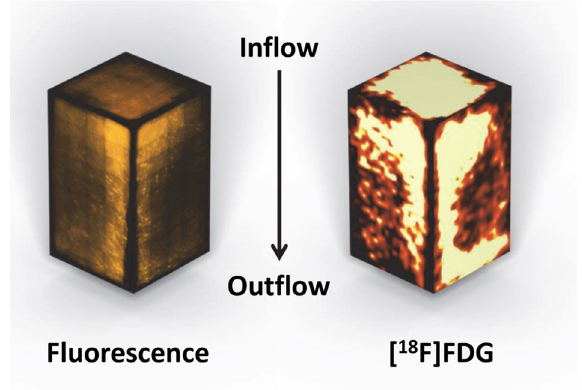
Figure 6. Comparison of fluorescence or [ 18 F]FDG-labeling of ASC for imaging the cell distribution within the scaffold block. Both techniques show similar stem cell distribution patterns in the scaffold. Therefore, both are suitable for imaging of cell